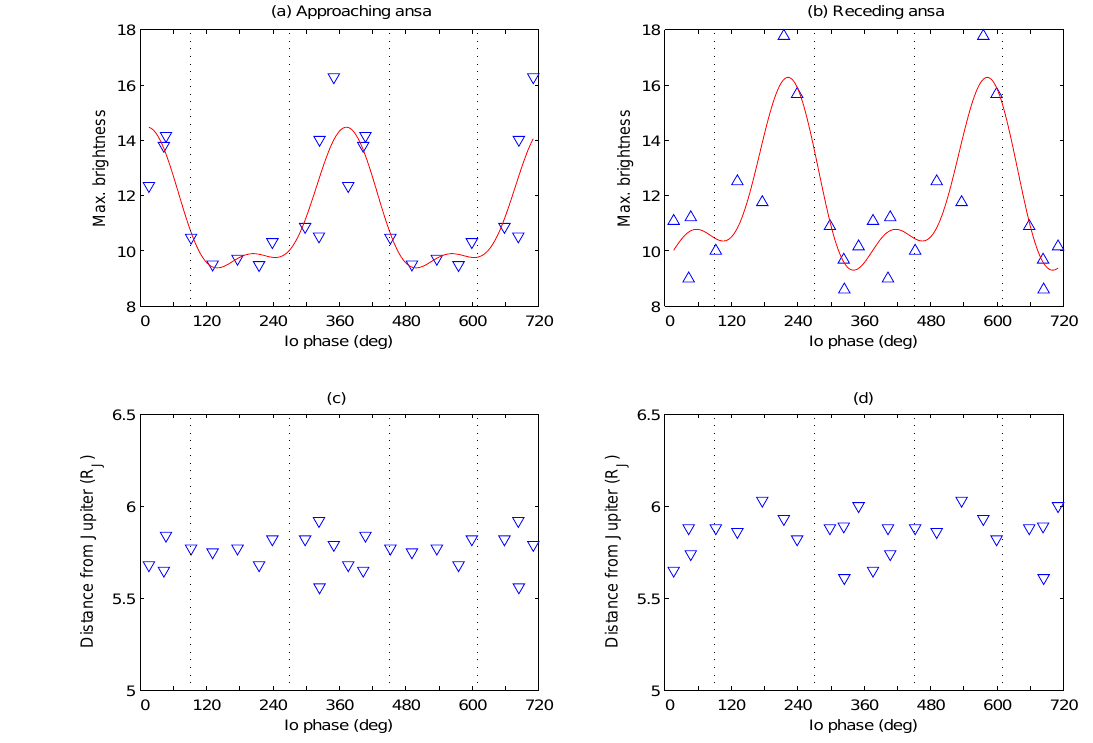
Figure 4. (a, b) The maximum relative brightness of the approaching (a, c) and receding (b, d) ansa as a function of the Io phase angle, with a second order Fourier fit superposed. (c, d) The ansa distance from Jupiter as a function of Io phase angle. Table 2. Averaged ansa locations from this paper and two of the largest continuous data sets of torus observations. Data Approaching Receding Angle Local from ansa ansa ground time Reference Voyager 2 5.97 R